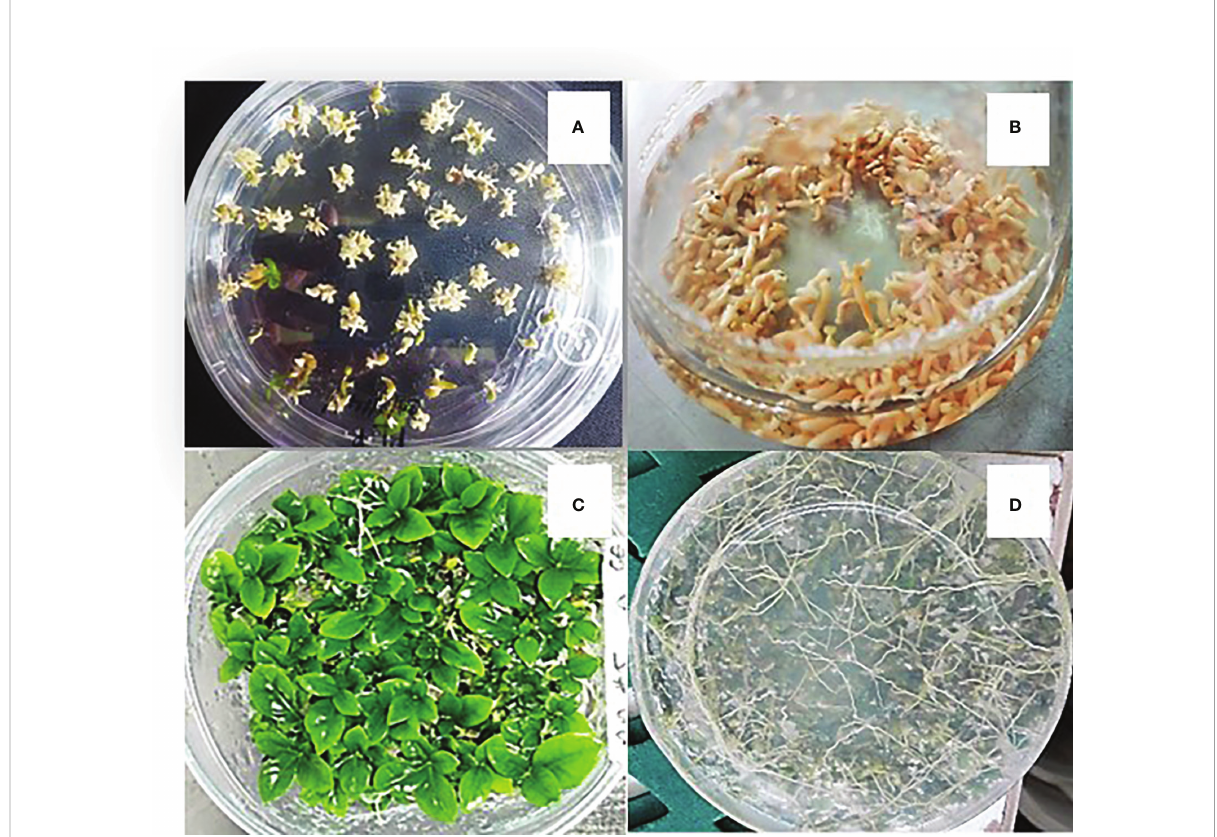
FIGURE 2 Germination of somatic embryos and conversion into plants in semi-solid T5 medium. (A) Regeneration of EC on semi-solid Yasuda medium; (B) pre-germination of embryos regenerated in liquid T5 medium in Erlenmeyer fl asks; (C) conversion into plants in semi-solid T5 medium; (D) plants showing root